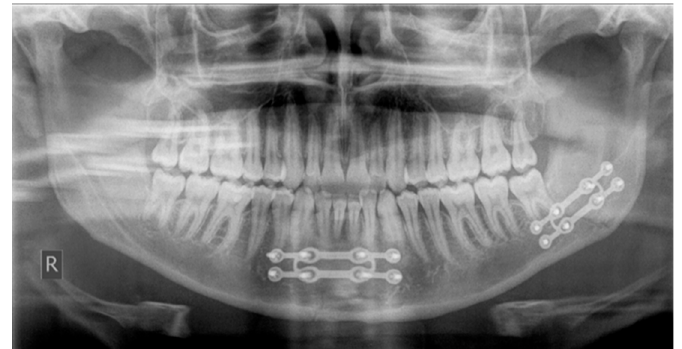
Figure 2. Double mandibular fracture treated with two Grid-Plates (Modus Trauma 2.0, Medartis).